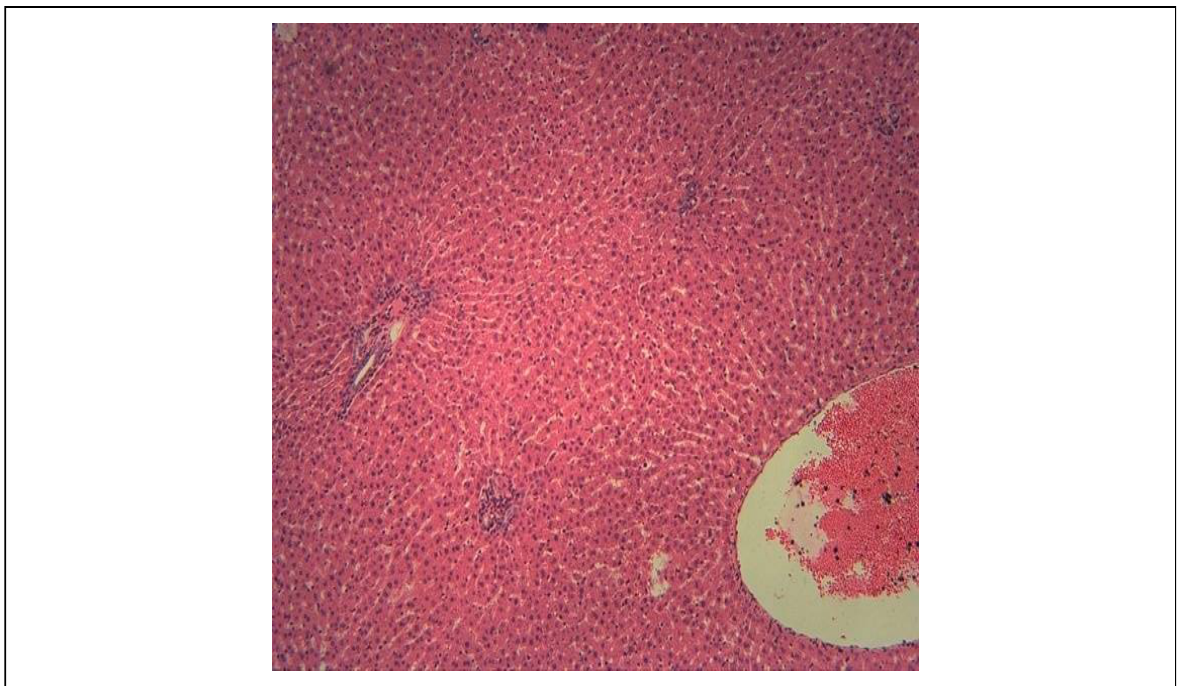
Photomicrographs of the liver section of normal control rats that received water and feed only (group 4) showed well preserved liver architecture with no histopathological leison, and normal central vein. (Mg. X400).